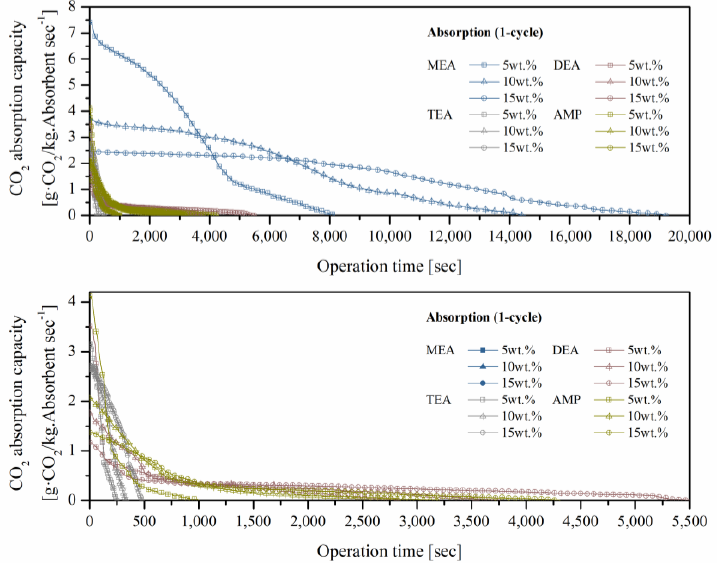
Figure 5. CO 2 absorption rates at 5, 10, and 15 wt.% aqueous MEA, DEA, TEA, and AMP in cycle 1 of multicycle IAM. The rate was evaluated by the amount of absorbed CO 2 in every 10 s (Tables S1–S12). In addition, DEA, TEA, and AMP patterns are more clearly displayed in the chart